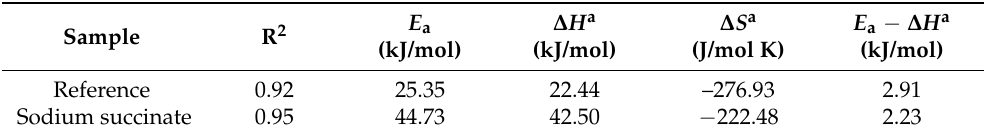
Figure 9. Transition state plot of carbon steel rebars in the presence and absence of 0.6 M sodium succinate in 0.6 Cl − SCPS.